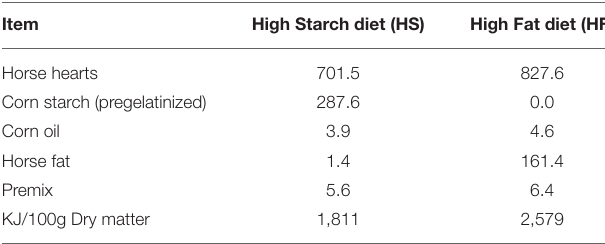
TABLE 1 | Formulation of the diets